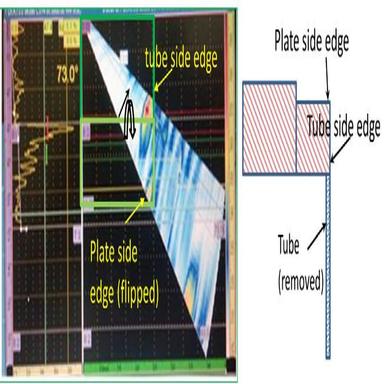
PAUT image of an FWTPET specimen with no defect.